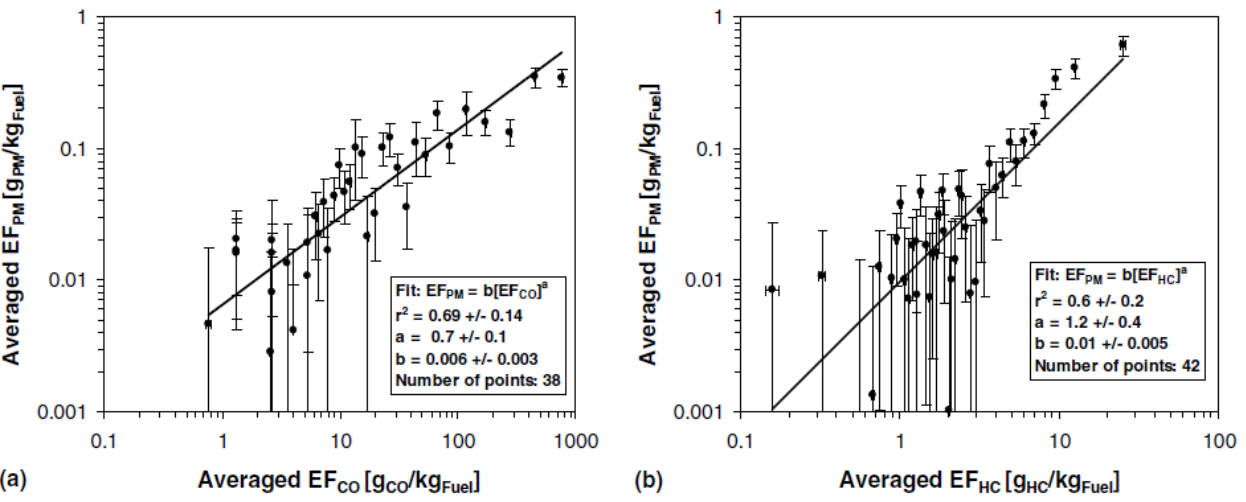
Figure 10. Average PM emission factors vs. CO ( a ) and vs. HC ( b ) emission factors